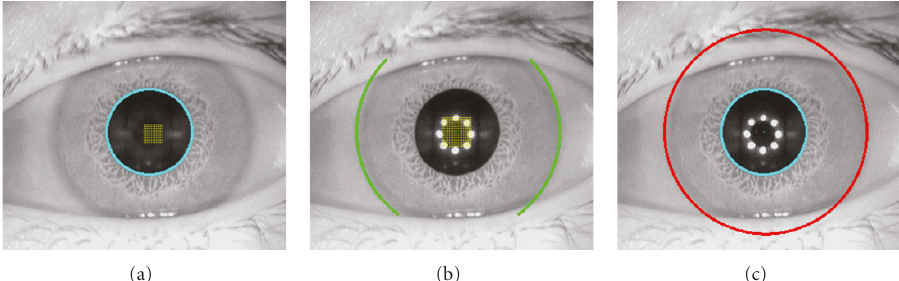
Figure 4: Iris boundary localization. (a) Estimation of the pupil contour by a circle (in yellow, the grid of the tested centres), (b) estimation of the outer iris contour by an ellipse, and (c) obtained result.